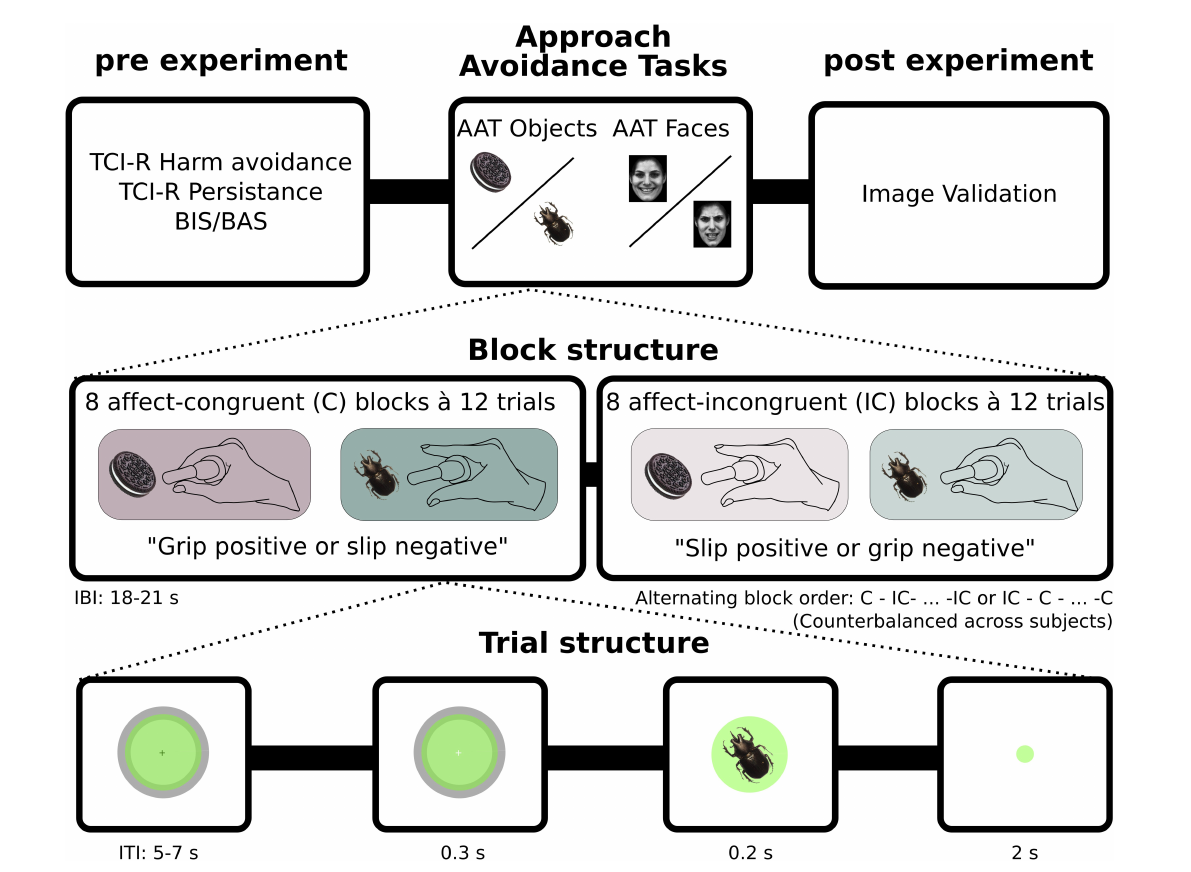
FIGURE2 Experimental structure. Prior to performing the two version of the approach avoidance task (AAT) (with Faces or Objects as stimuli) participants filled out questionnaires and received training on the task. The AAT-Faces consisted of 16 blocks, whereof 8 were with affect-congruent instructions (grip positive and slip negative) and 8 were with affect-incongruent instructions (slip positive and grip negative). The AAT-Objects task had an additional 4 blocks with neutral cues (not depicted here, see methods). Each block in turn consisted of 12 trials, with equally many positive as negative images presented in a pseudorandomized order. Each trial began with participants exerting force at baseline level (2% of MVC). Once baseline level was obtained and participants had held it constant for minimum 1 s, the circle on the screen, giving visual feedback of force input, changed color from green to blue, indicating the start of the trial. Shortly thereafter, stimuli appeared on the screen for 0.2 s. Participants were instructed to respond as fast and as accurately as possible according to block